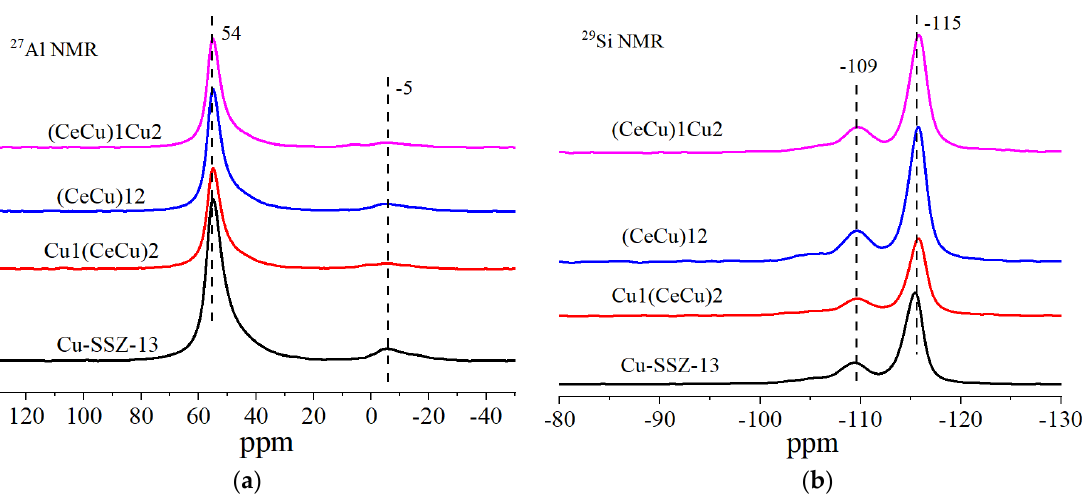
Figure 4. Solid state 27 Al ( a ) and 29 Si ( b ) MAS NMR spectra of Cu-SSZ-13 and Ce-modified Cu-SSZ-13 catalysts.